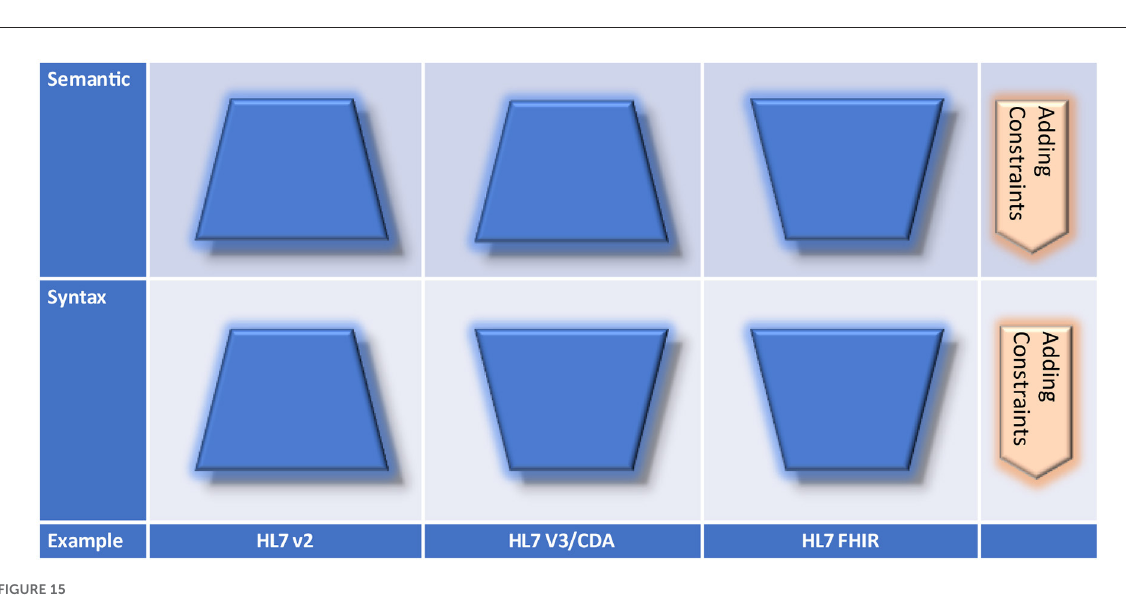
FIGURE15 Creating specifications by